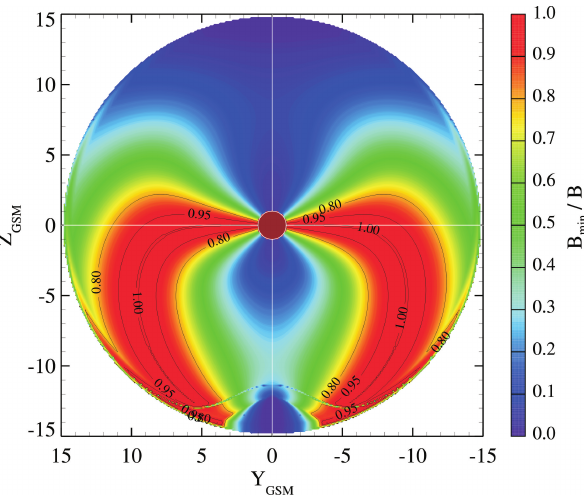
Figure 12. Distribution of the inverse mirror ratio ε in a vacuum magnetic configuration with a tilted dipole field, shielded within a T96 model magnetopause. The diagram corresponds to the termina- tor plane ( X GSM =